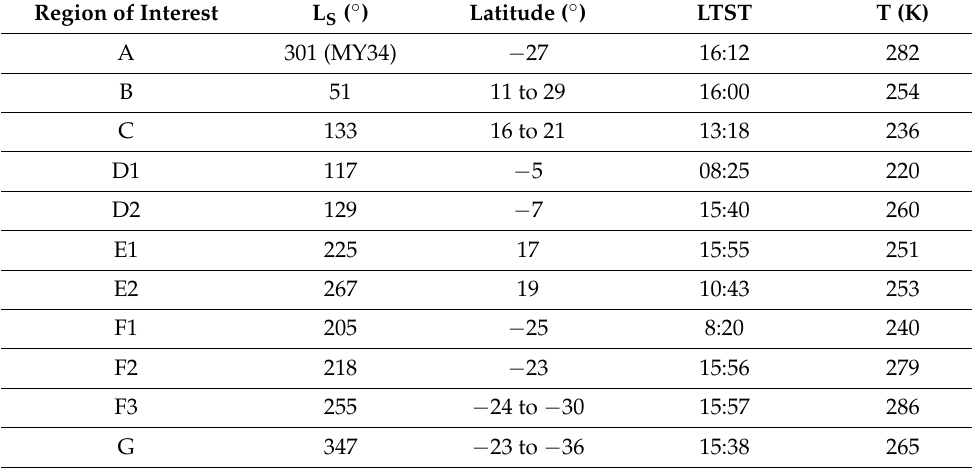
Figure 5. FCI values distribution in logarithmic X-scale for MY34-35. Solid black line: mean value of the distribution ( µ = − 0.35). Dashed black line: standard deviation of the distribution ( σ = 0.13). Dashed red line: mean value of FCI at the polar cap edge ( µ + 3.5 σ ). Dashed blue line: mean value of FCI on the polar cap deposits ( µ + 10 σ ). Table 2. Solar longitudes (L S ), latitudes, local times (LTST), and MCD predicted surface temperatures (T) of the regions of interest (A to F) identified in Figure 6. Numbers in the regions D, E, and F represent bins from left to right in each